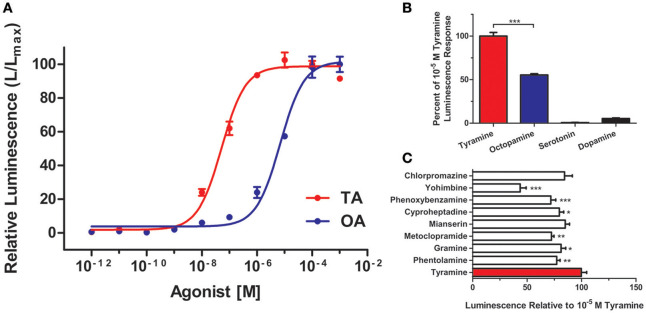
Functional characterization of R. prolixus Tyr1 receptor in HEK293 cells. (A) Dose-response curve showing the effects of tyramine (TA) and octopamine (OA) on the RhoprTyr1-R. (B) RhoprTyr1-R is more selective for tyramine. (C) Various biogenic amine antagonists, notably yohimbine and phenoxybenzamine, reduced the tyramine-induced activation of the RhoprTyr1-R (One-Way ANOVA followed by Dunnett's Multiple Comparison Test compared to tyramine groups at 100%, *P < 0.05, **P < 0.01, ***P < 0.001). All receptor agonists and antagonists were tested at 10−5 M. Data represents the mean ± SEM of n = 3–6 per treatment.